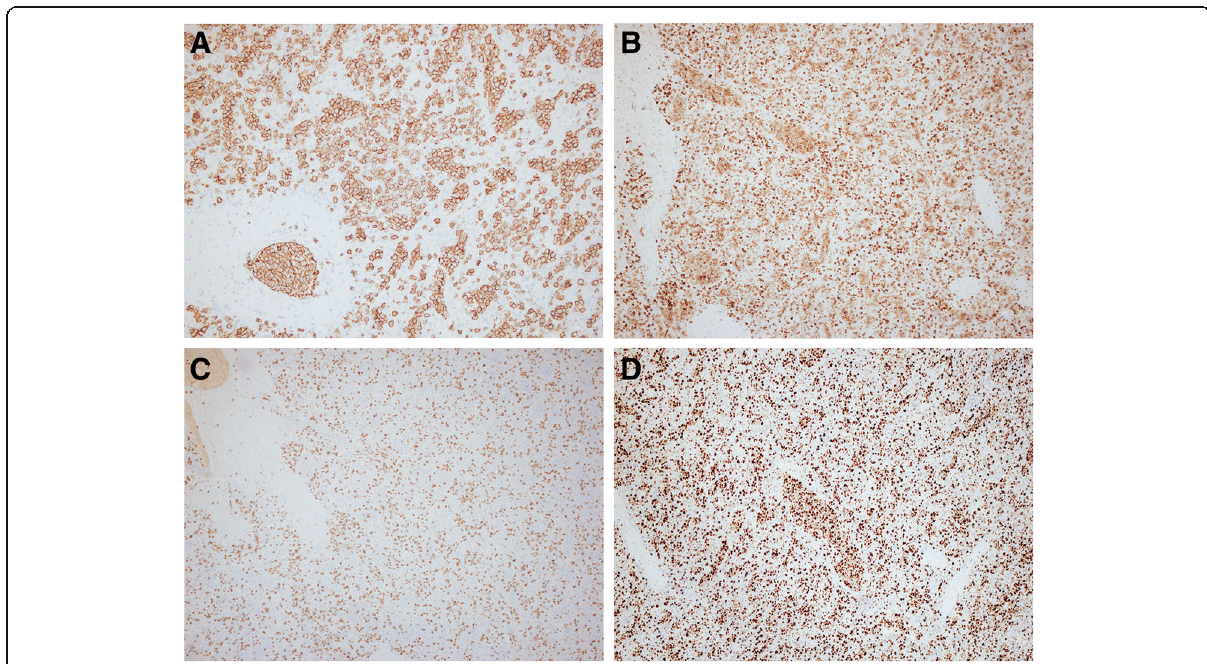
Fig. 3 Immunohistochemical features of the spleen. The lymphomatous cells were positive for CD20 ( a ), CD5 ( b ); and negative for CD3 ( c ). Ki – 67 proliferative index was about 80% ( d )